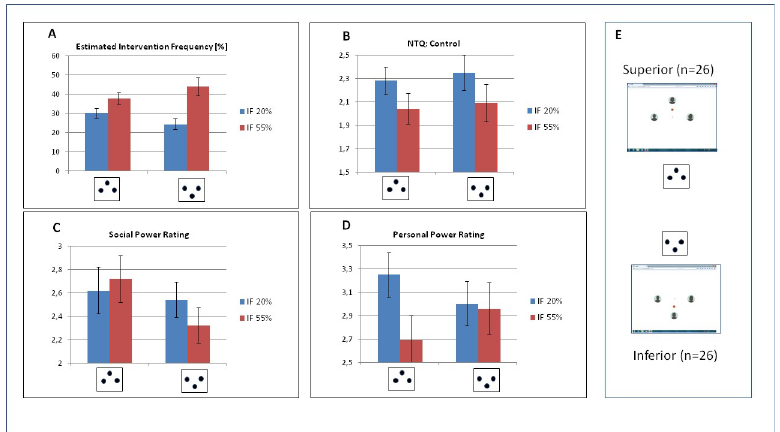
Fig 2. Descriptive statistics for the self-report data, separated for experimental factors ‘position’ (inferior vs. superior) and ‘intervention frequency’ (IF 20% vs IF 55%). Error bars refer to the standard error of mean. (A) Estimated frequency of intervention was overestimated by participants in superior position in the first block. (B) The threat to the need for control was increased by increasing intervention frequency. (C) Ratings of self-assigned social power were not affected by experimental manipulation. (D) In contrast, ratings of self-assigned personal power were reduced by increasing the intervention frequency, but exclusively in the superior group. (E) Explanation of the pictograms used.